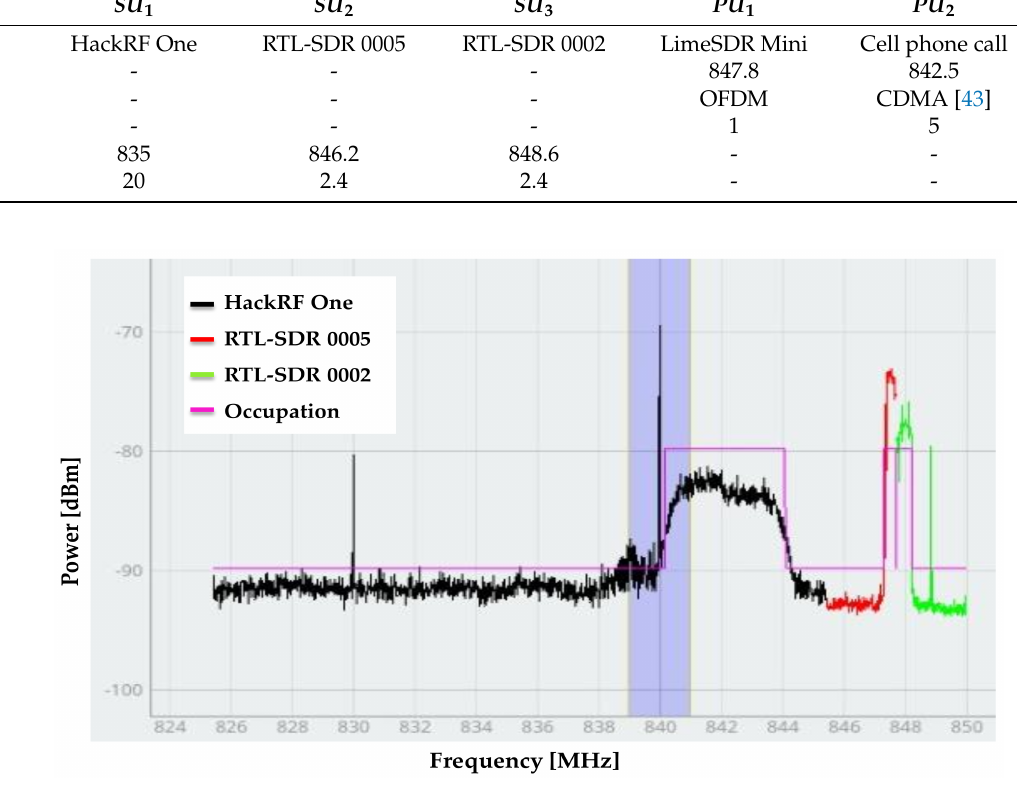
Figure 16. Frequency range perceived by SU s